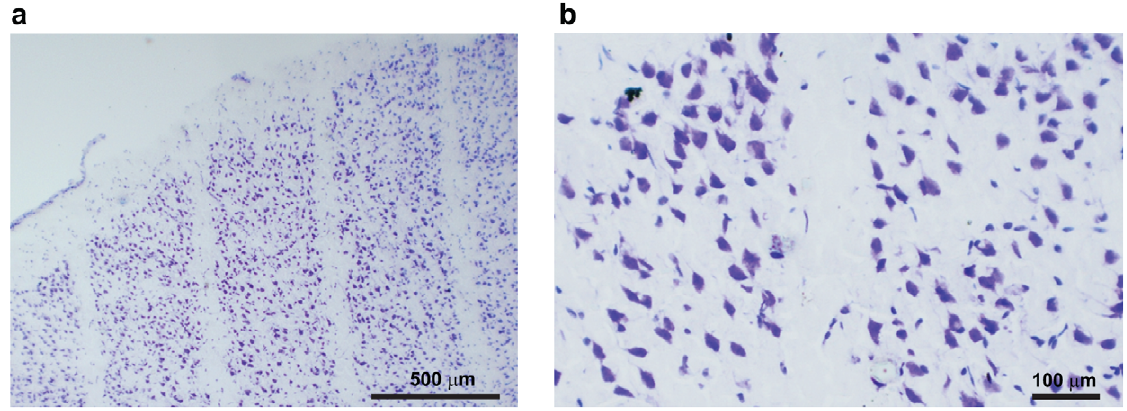
Figure 5. Nissl staining of sensory motor cortex. Nissl analysis performed 7 months after microbeams irradiation shows the lack of neurons along the microbeam path whereas neurons are spared in between microbeams (5b is a higher magnification of